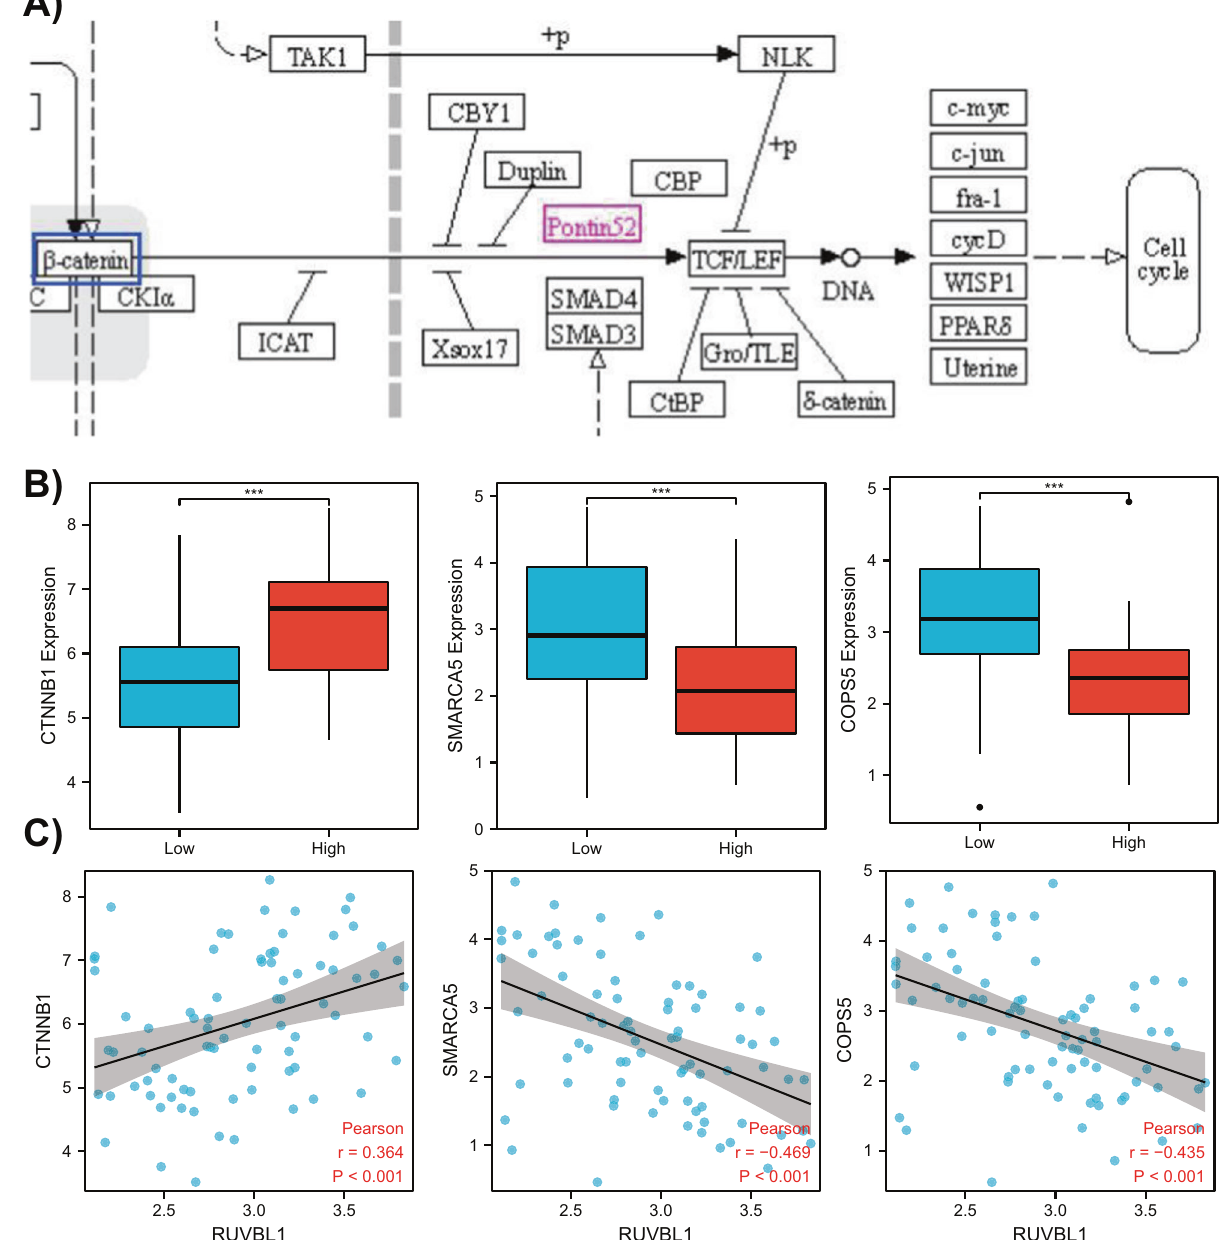
Fig. 4 Correlation analysis between RUVBL1 and CTNNB1. A RUVBL1-related signaling pathway diagram of KEGG database (Pontin53 is the target gene RUVBL1, and the blue box is the downstream gene CTNNB1). B Expression of CTNNB1, SMARCA5, and COPS5 in the high and low RUVBL1 expression groups (the red column shows the expression level in the high expression group, and the blue column shows the expression level in the low expression group). C Pearson correlation analysis between CTNNB1, SMARCA5, or COPS5 and RUVBL1, respectively (each point is the expression level of RUVBL1 and one related gene in the same sample, p < 0.001 indicates a signi fi cant